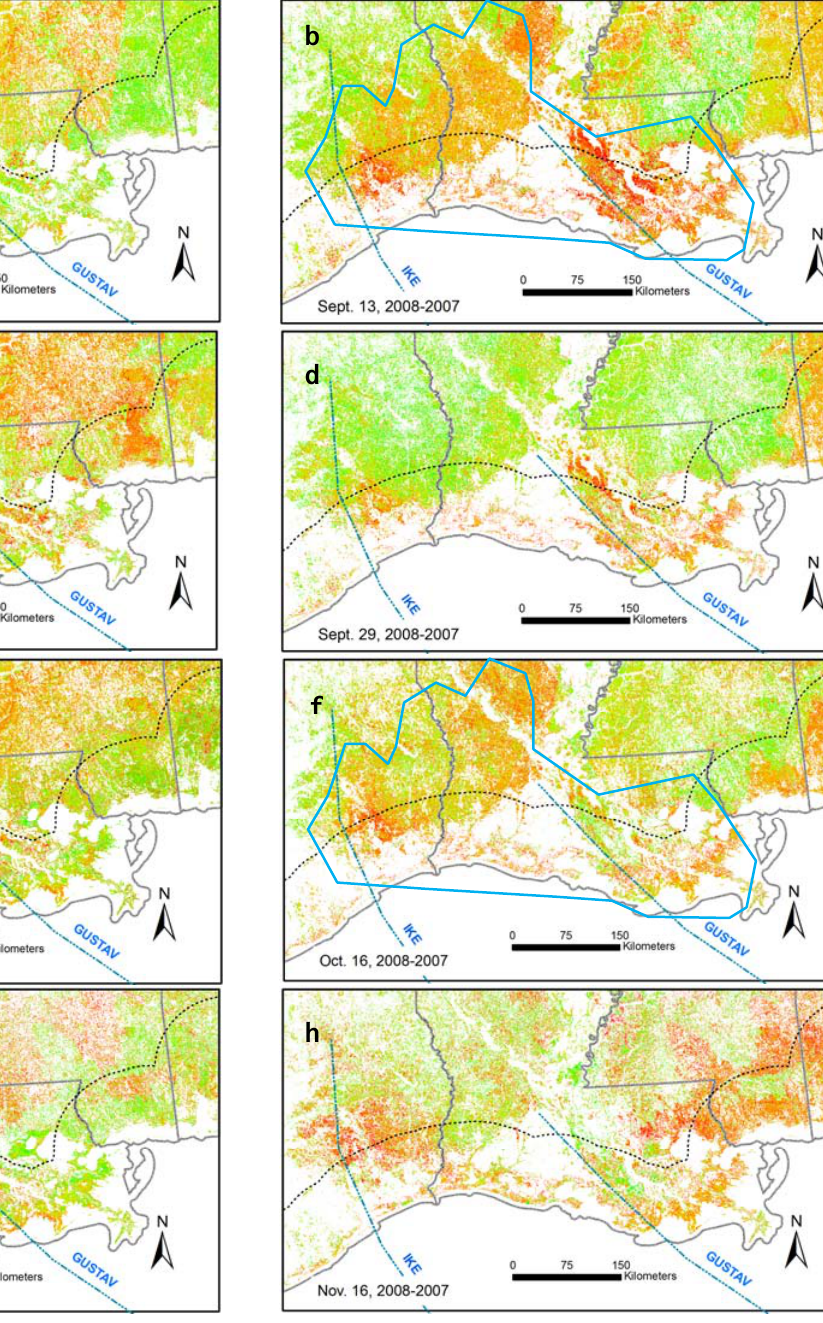
Figure 9. (a, c, e, and g) Percentage changes of MODIS EVI values in the years without hurricane disturbance. (b, d, f, and h) Changes in the EVI value after Gustav and Ike made their landfalls on September 1 and 13, 2009. The map legend is the same as Figure